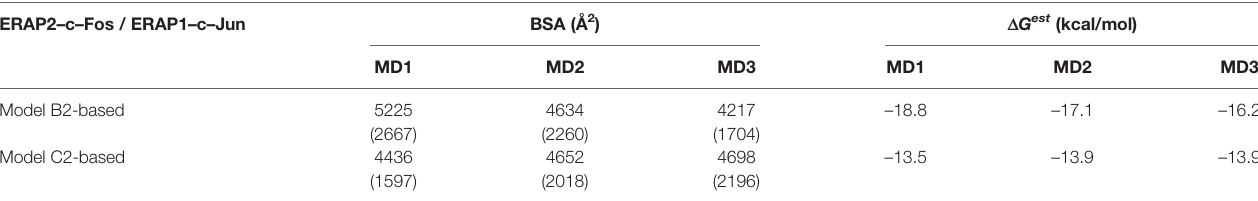
TABLE 3 | Summary of mean buried surface area (BSA) and mean estimated binding free energy ( D G est ), calculated from triplicate 100 – ns MD simulations of ERAP1 – c- Jun/ERAP2 – c-Fos starting from the preferred ERAP2 – based topology (model B2) and in comparison with an IRAP – based topology (model C2). ERAP2 – c – Fos / ERAP1 – c –